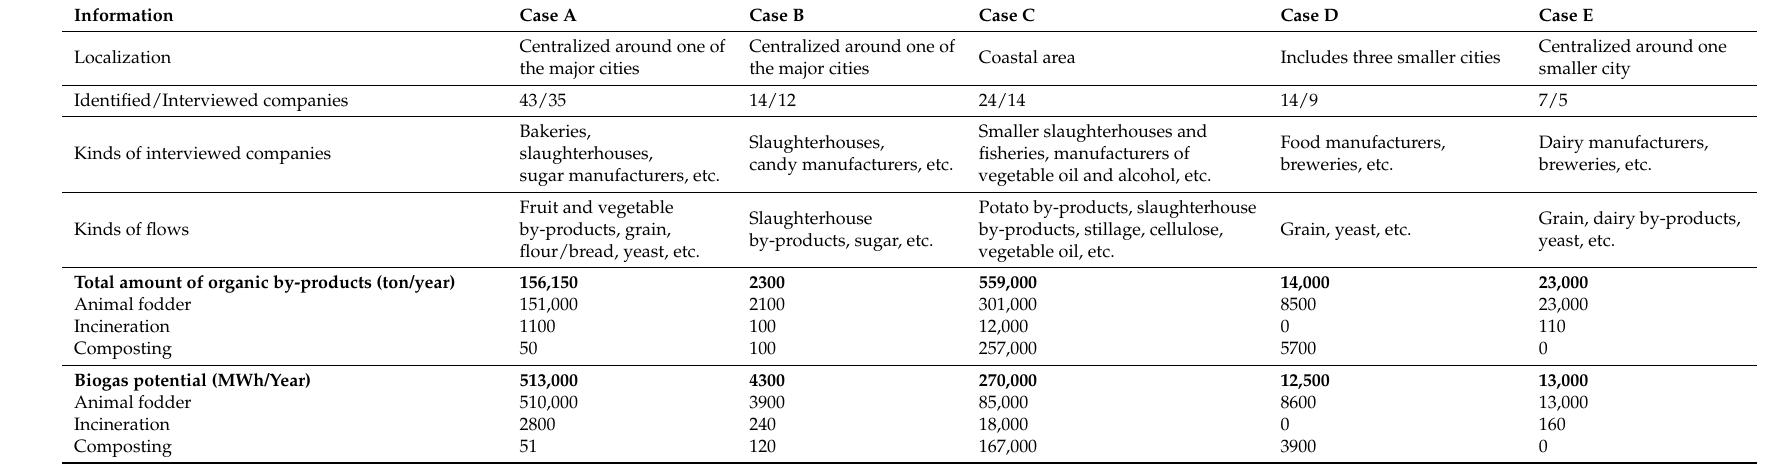
Table 2. Compilation of information about the cases